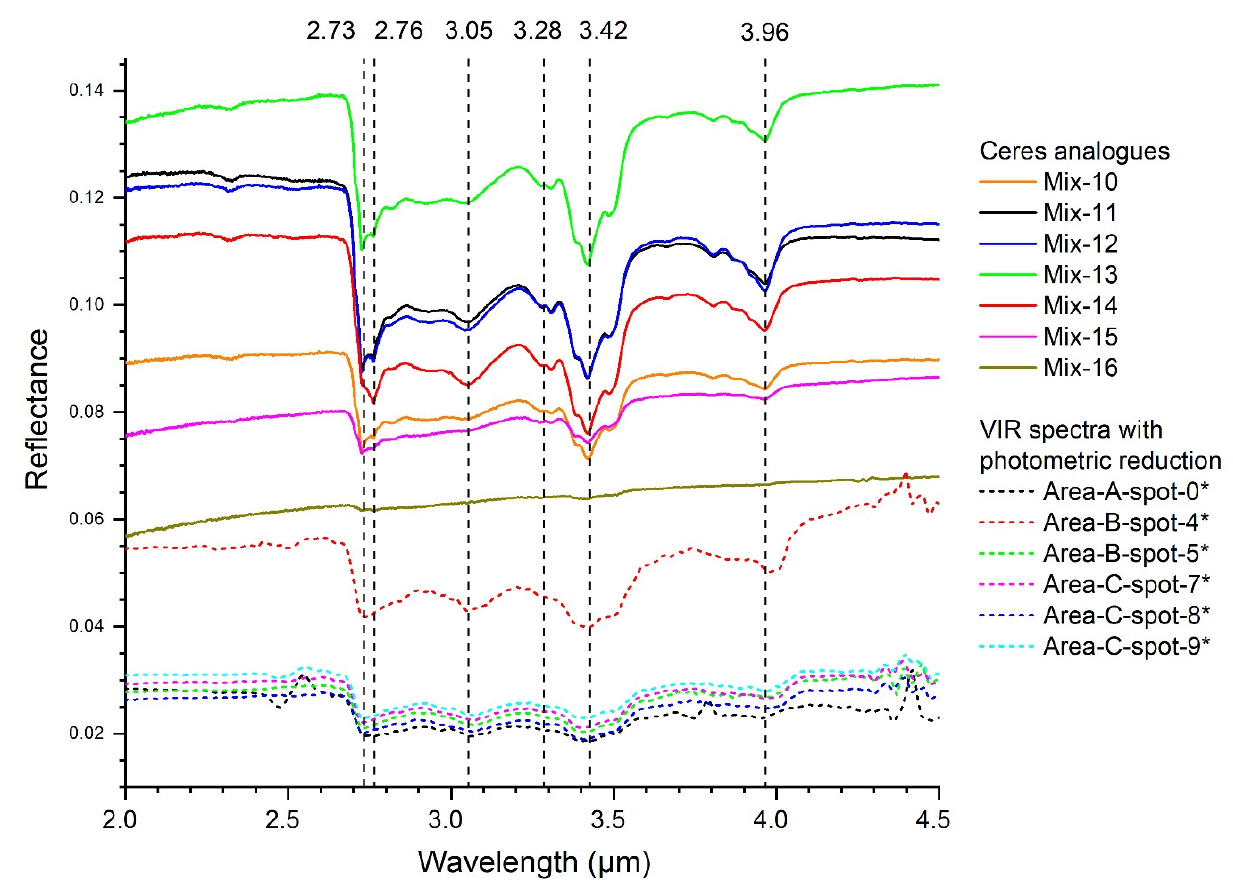
Figure 5. IR reflectance spectra of the mixtures (solid lines) compared to VIR spectra (dashed lines) after photometric reduction (* see Methods and Analyses section). Vertical dashed lines point at major bands for each sample that also correspond to major bands observed in Ceres’ spectra; 2.73–2.76 µ m: stretching OH from hydroxyl groups in phyllosilicate; 3.05 µ m: stretching NH from ammonium ions NH 4+ ; 3.28 µ m: stretching CH from aromatic carbon groups; 3.42 µ m: stretching CH from aliphatic carbon group; 3.96 stretching CO 3 from carbonates. Reflectance level of the mixtures ranges between 0.06 to 0.14 compared to the reflectance levels at various spots on Ceres (0.03 I/F). Photometric corrected spectrum of Area-B spot-4 appear brighter, likely due to higher abundance of carbonate